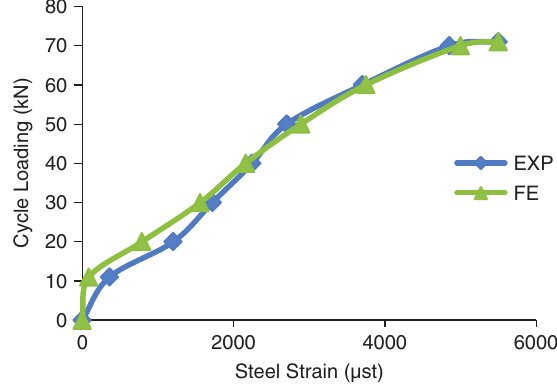
Fig. 10. Load against steel strain curves for beam G1D